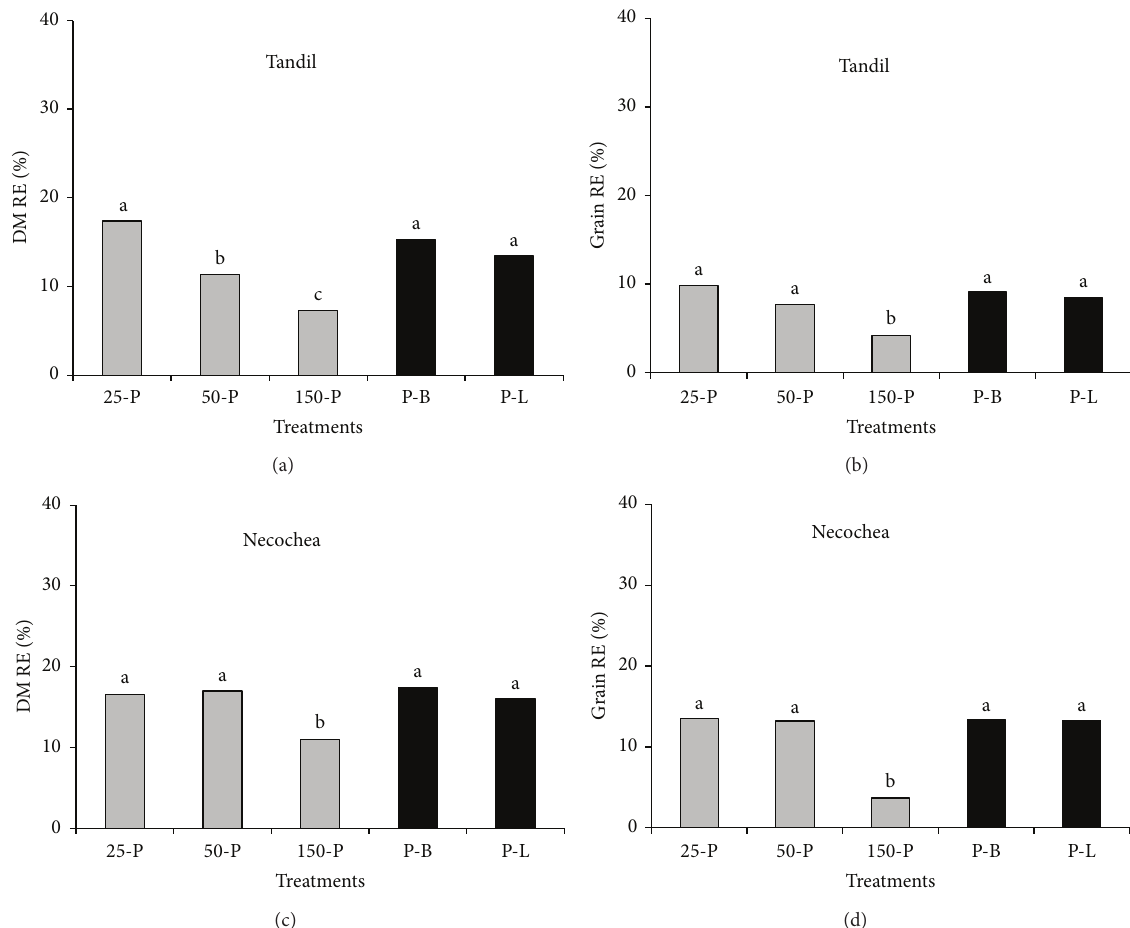
Figure 3: Phosphorus recovery efficiency (PRE) in dry matter (DM = grain + residues) and grain of NT wheat as affected by placement method and P rate. Means followed by the same letter are not significantly different from each other based on the Duncan test (0.05). Phosphorus response is compared using 25, 50, and 150P rates (gray). Phosphorus placement method is only compared at 25 and 50 P rates (black). P-B; phosphorus broadcasted. P-L: phosphorus banded at